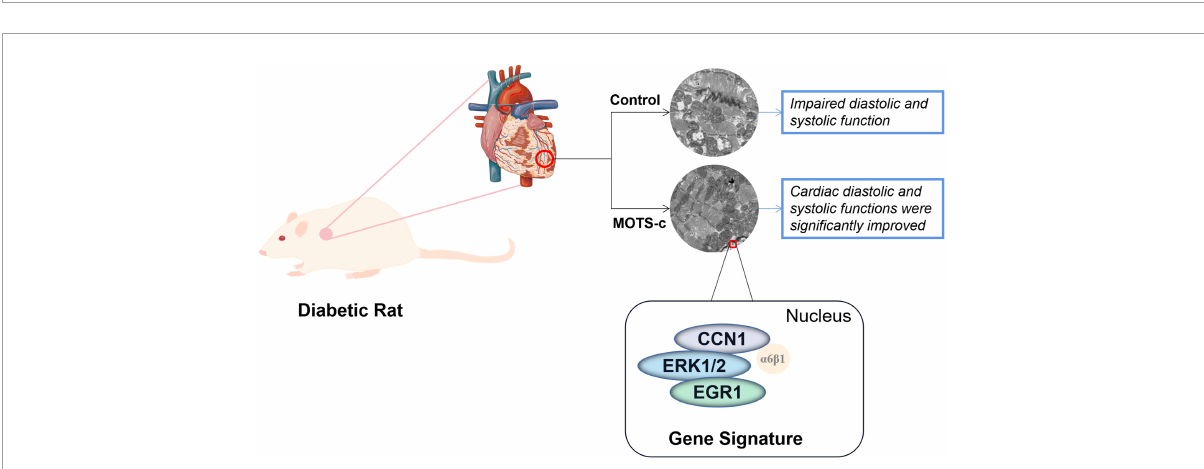
FIGURE8 A conceptual model of MOTS-c improving myocardial injury in diabetic rats by inhibiting CCN1/ERK/EGR1 expression. Change: Cardiac diastolic and systolic functions were significantly improved to: Improved cardiac diastolic and systolic